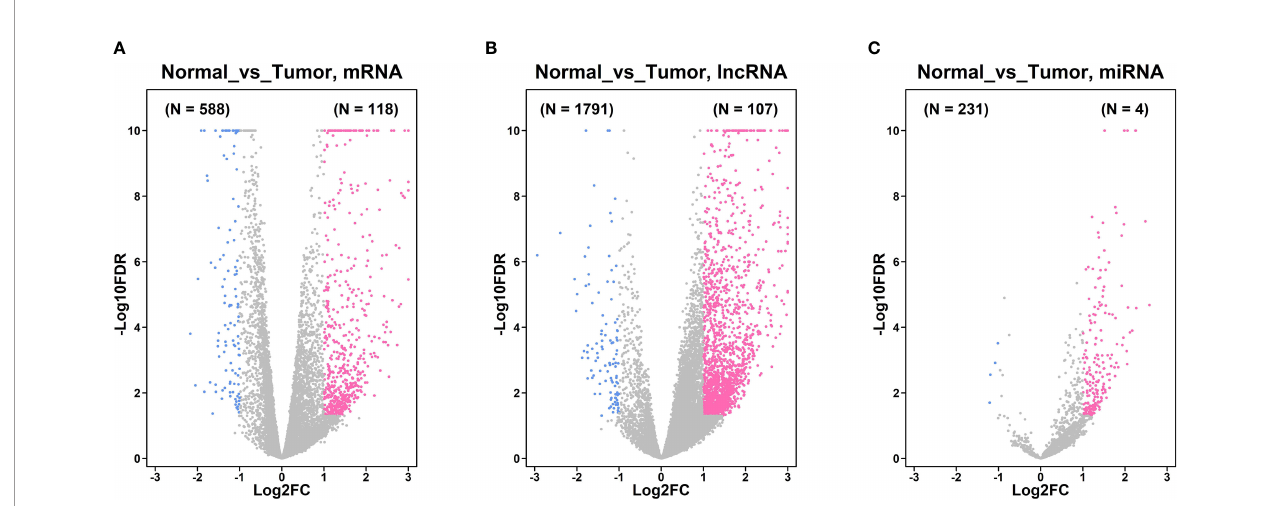
FIGURE 1 | Differentially expressed genes in gastric cancer tissues and normal gastric tissues from TGCA database. (A) Volcano plot of the differentially expressed mRNA between gastric cancer tissues and normal gastric tissues. (B) Volcano plot of the differentially expressed lncRNA between gastric cancer tissues and normal gastric tissues. (C) Volcano plot of the differentially expressed miRNA between gastric cancer tissues and normal gastric tissues. Pink dots represent up-regulated mRNA or lncRNAs; blue dots represent down-regulated mRNA or lncRNAs; grey dots represent non-signi fi cantly expressed mRNA or